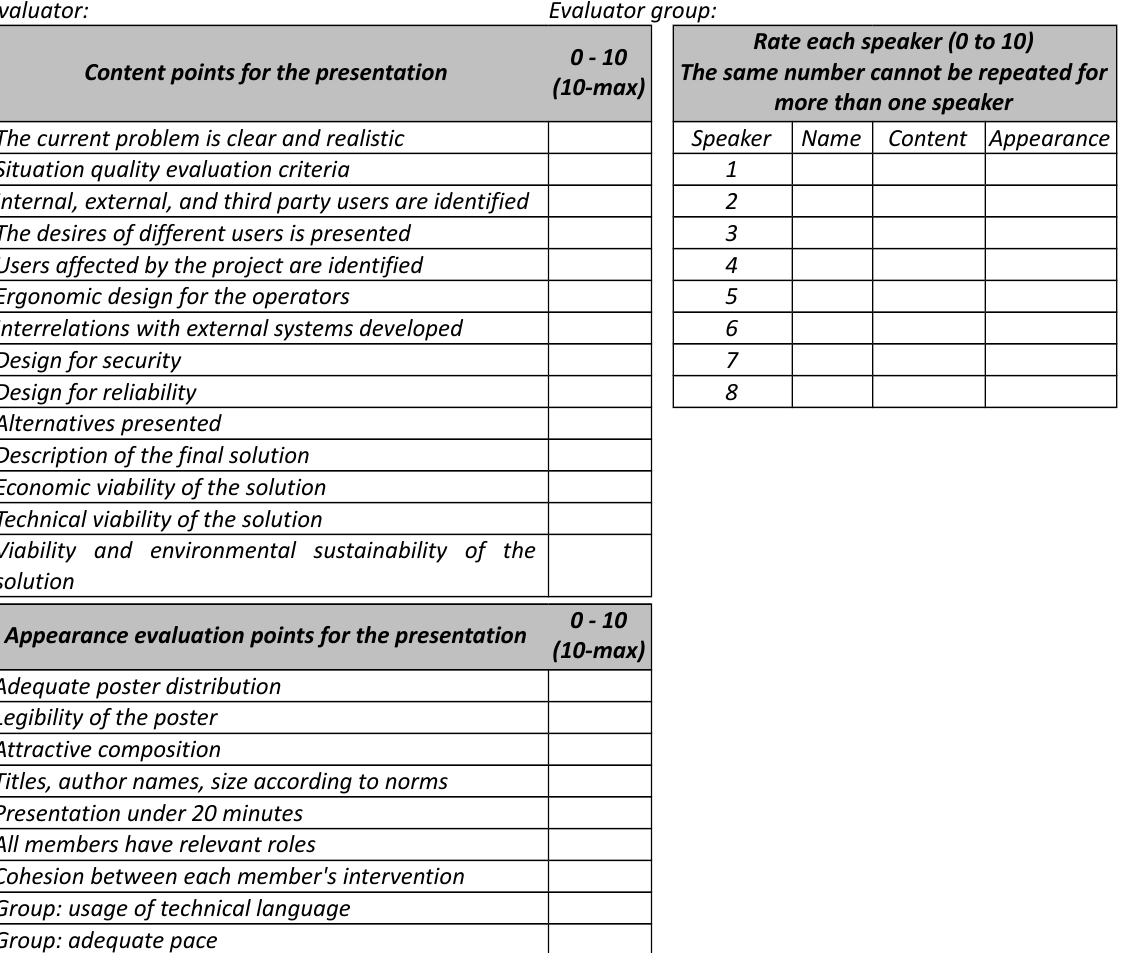
Figure 2. Rubric used for peer